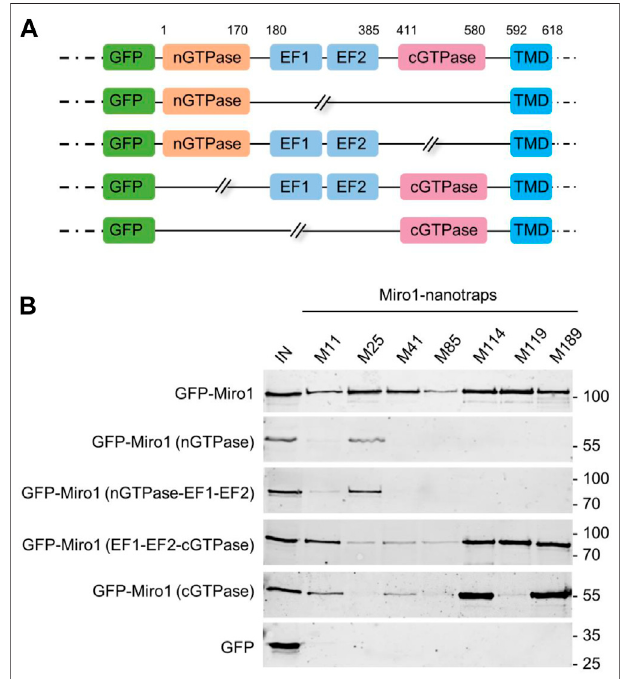
FIGURE 3 | Domain mapping ofMiro1-Nbs. (A) Schematic illustration of GFP-labelledMiro1deletionconstructsanddomainsusedfordomainspeci fi c binding studies. (B) Soluble protein fractions of HEK293 cells transiently expressing indicated Miro1 deletion constructs or GFP (as control) were subjected to immunoprecipitation with selected Miro1 nanotraps followed by western blot analysis of input (IN) and bound fractions with an anti-GFP